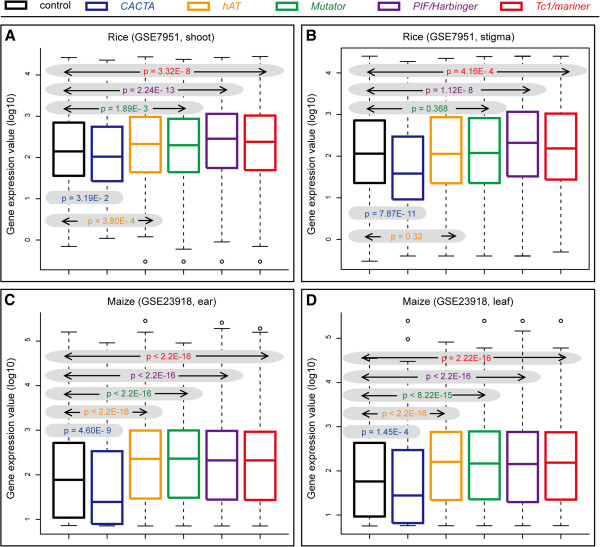
Comparison between the expression levels of genes with class 2 TEs and without class 2 TEs, in rice root (A) and stigma (B), maize ear (C) and leaf (D). The y-axis is log10 gene expression values. P-values of pairwise comparison are shown in shadow areas. Colors of superfamilies are the same as in Figure 
1.